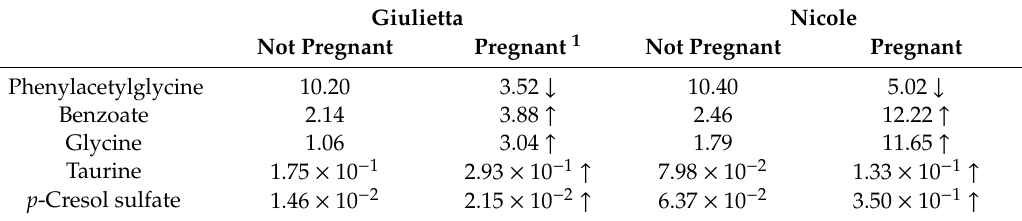
Table 2. Urinary metabolites (mmol / L) affected by pregnancy consistently across the two giraffes